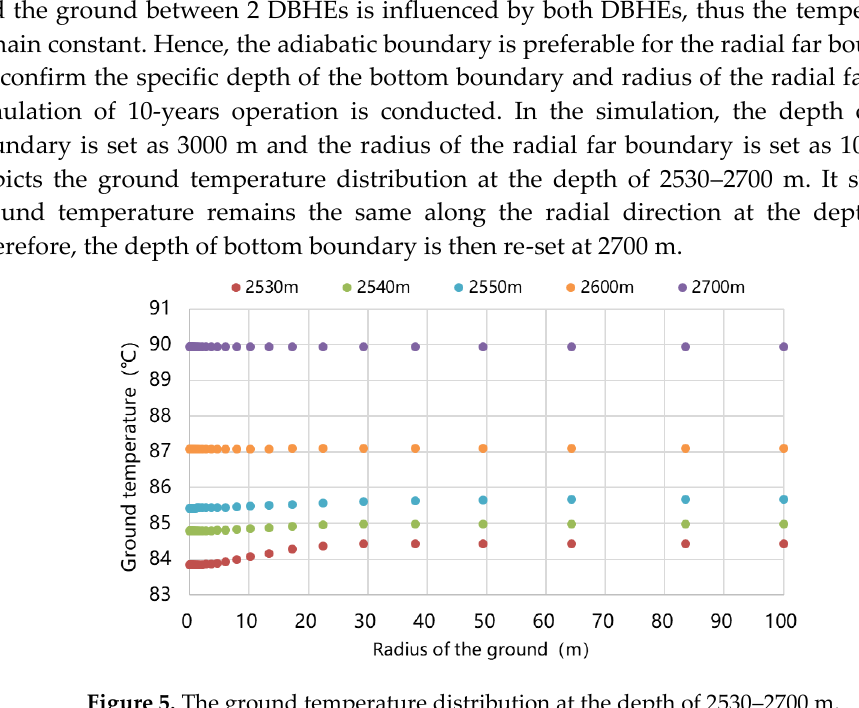
Figure 5. The ground temperature distribution at the depth of 2530 – 2700 m.